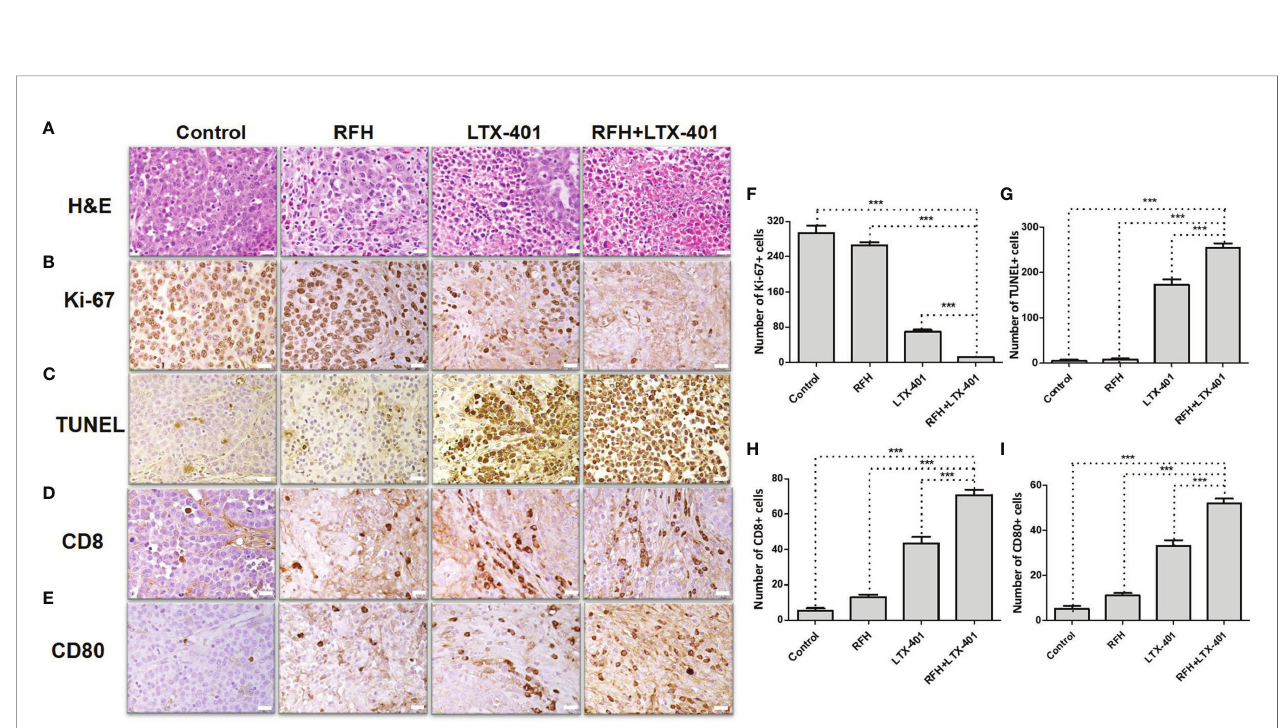
FIGURE 9 | Pathology con fi rmation. (A) H&E images demonstrate a nuclear atrophy and hyperchromatism, as well as the reduction in cell size with the combination therapy of RFH + LTX-401. (B, F) Ki-67 staining shows a signi fi cant inhibition of cancer cell proliferation in the combination therapy group, as evidenced by the fewest number of brown-stained cells (***= P <0.005). (C, G) TUNEL assay further con fi rms signi fi cantly increased apoptotic index in combination therapy group, as evidenced by the highest number of brown-stained cells (***= P <0.005). (D, H) CD8 staining and (E, I) CD80 staining further demonstrate the highest number of brown-stained cells in combination therapy group (***= P <0.005), in comparison to other monotherapy groups. (Scale bars, 20 m